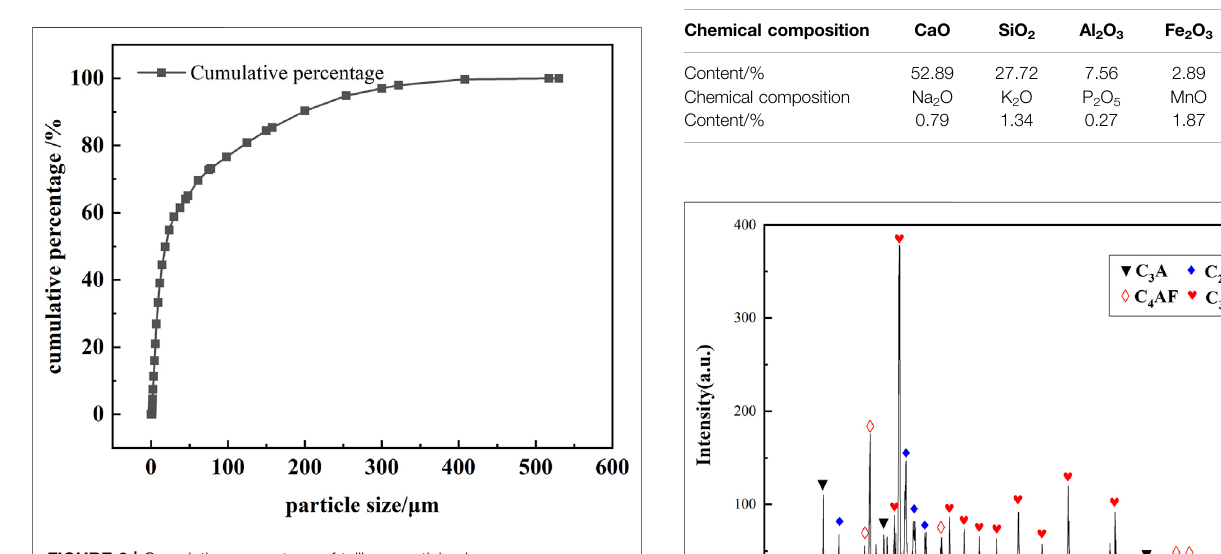
FIGURE 3 | Cumulative percentage of tailings particle size.